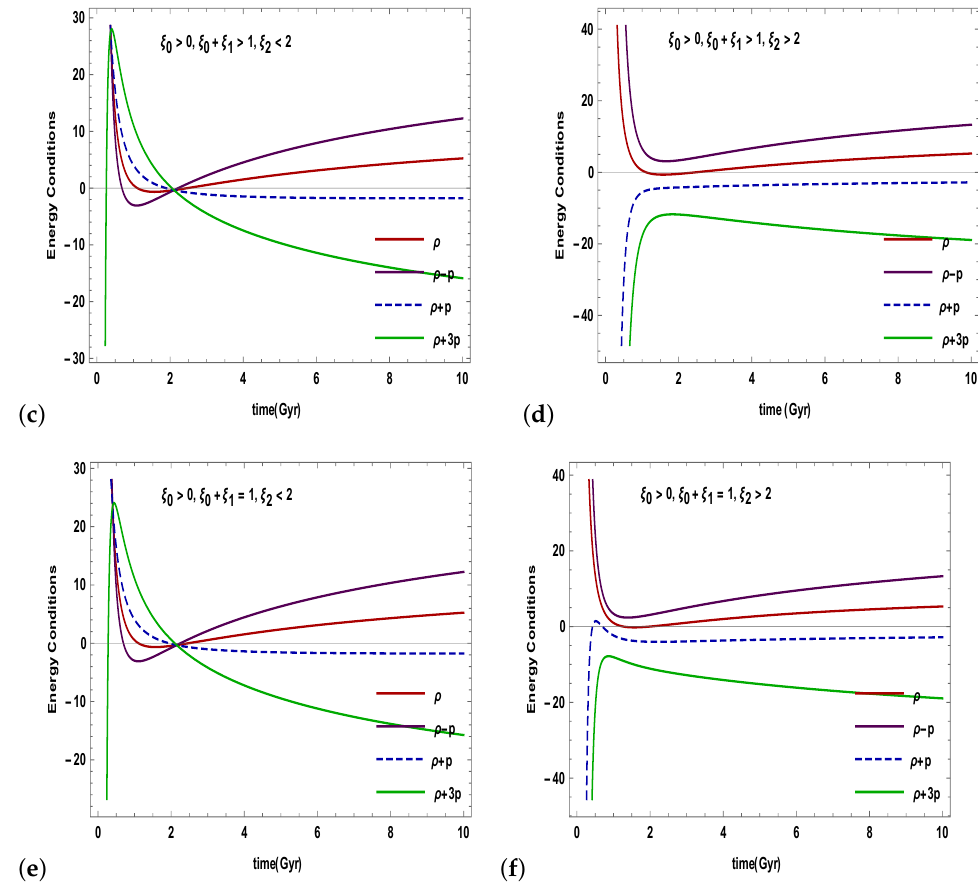
Figure 4. The variation of energy condition versus time t for various bulk viscosity